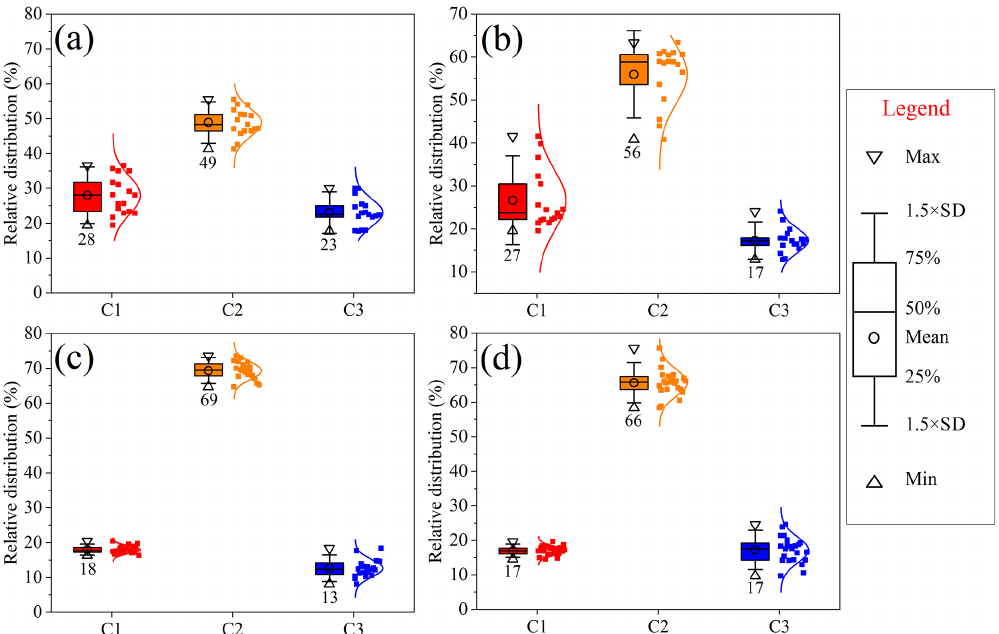
Figure 4. Relative contribution of individual fluorophores of atmospheric WSOM for (a) Chuzhou (CZ), (b) Guangzhou (GZ), (c) the wet season in GZ, and (d) the dry season in GZ. The colored box represents the data range of 25%–75%; the horizontal line within the box represents the median line (50%); the error bars represent 1.5 times the standard deviation; the circle in the box represents the mean value of the data; the triangles at the bottom and top represent the minimum and maximum values of the data, respectively; and the dots to the right of the box represent the overall data coupled with the Gaussian distribution